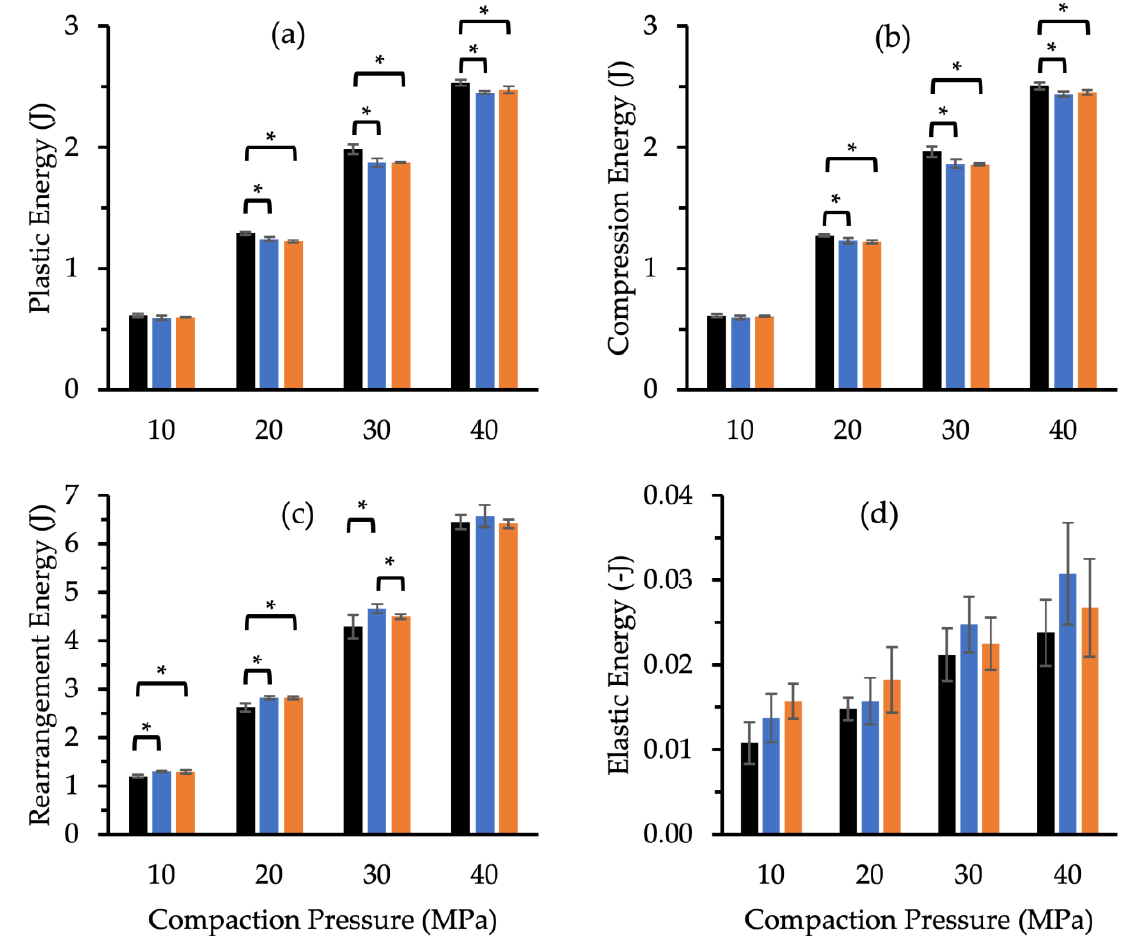
Figure 3. Compaction energy data obtained from the Analis software for control tablets ( (cid:4) ) ( n = 5) and MUPS tablets ( n = 4) containing MCC ( (cid:4) ) or XPVP pellets ( (cid:4) ) compacted at various compaction pressures, comprising ( a ) plastic, ( b ) compression, ( c ) rearrangement, and ( d ) elastic energy. Error bars indicate the standard deviation and * denotes a significant ( p < 0.05) difference.